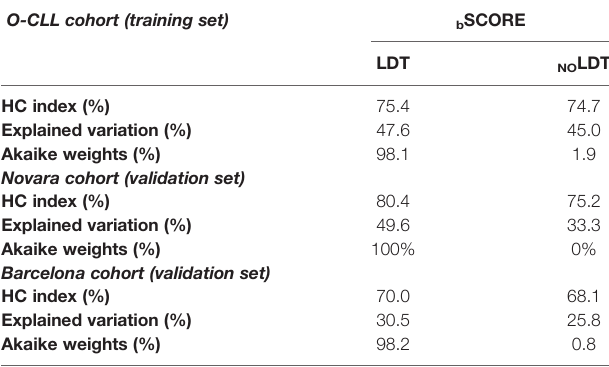
TABLE 3 | Comparison between the NO LDT score and the LDT score for the prediction of TTFT in the O-CLL, in the O-CLL, Novara, and Barcelona cohorts by regression coef fi cients ( B